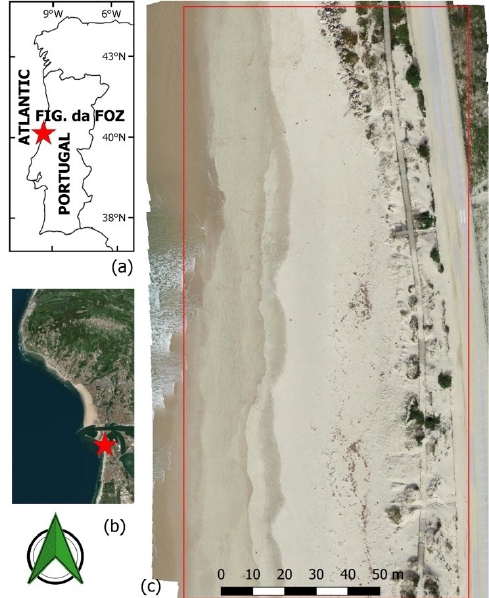
Figure 1 Study site map (a and b) and the orthophoto used in this work